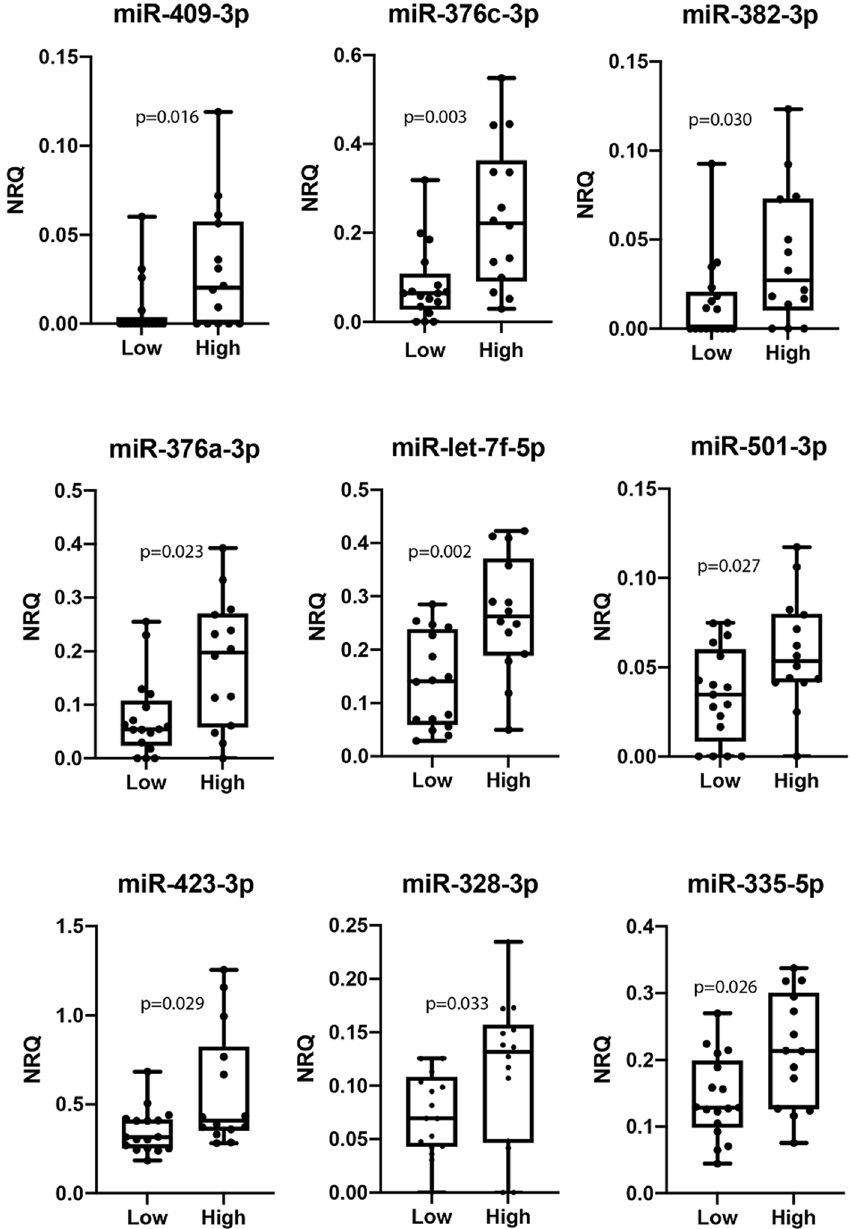
Figure 5. Differential expression of miRNAs in plasma samples from CAD patients exposed to low and high levels of PM 2.5 . Box and whiskers Min to Max plots showing plasma levels of microRNAs from CAD patients (n = 31) exposed to low or high levels of PM 2.5 . Including all clinical presentations in the analysis, high PM 2.5 short-term exposure was associated with ( A ) increased and ( B ) decreased miRNA expression. Differences were analyzed using Mann–Whitney U